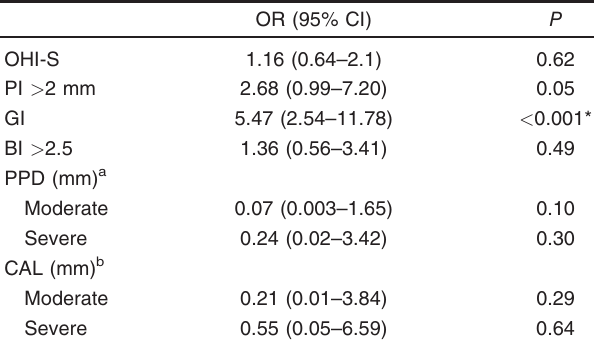
Table 4 Logistic regression for frequency of exacerbations concerning patients ’ periodontal health variables